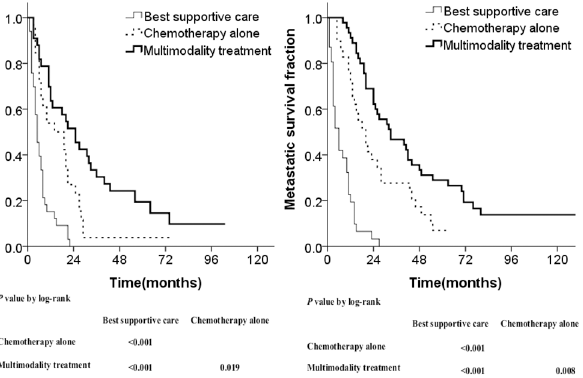
Fig 4. Metastatic survival curves stratified by treatment modalities in different disease-free intervals (DFI): DFI < 1 year (A) and DFI > 1 year (B).